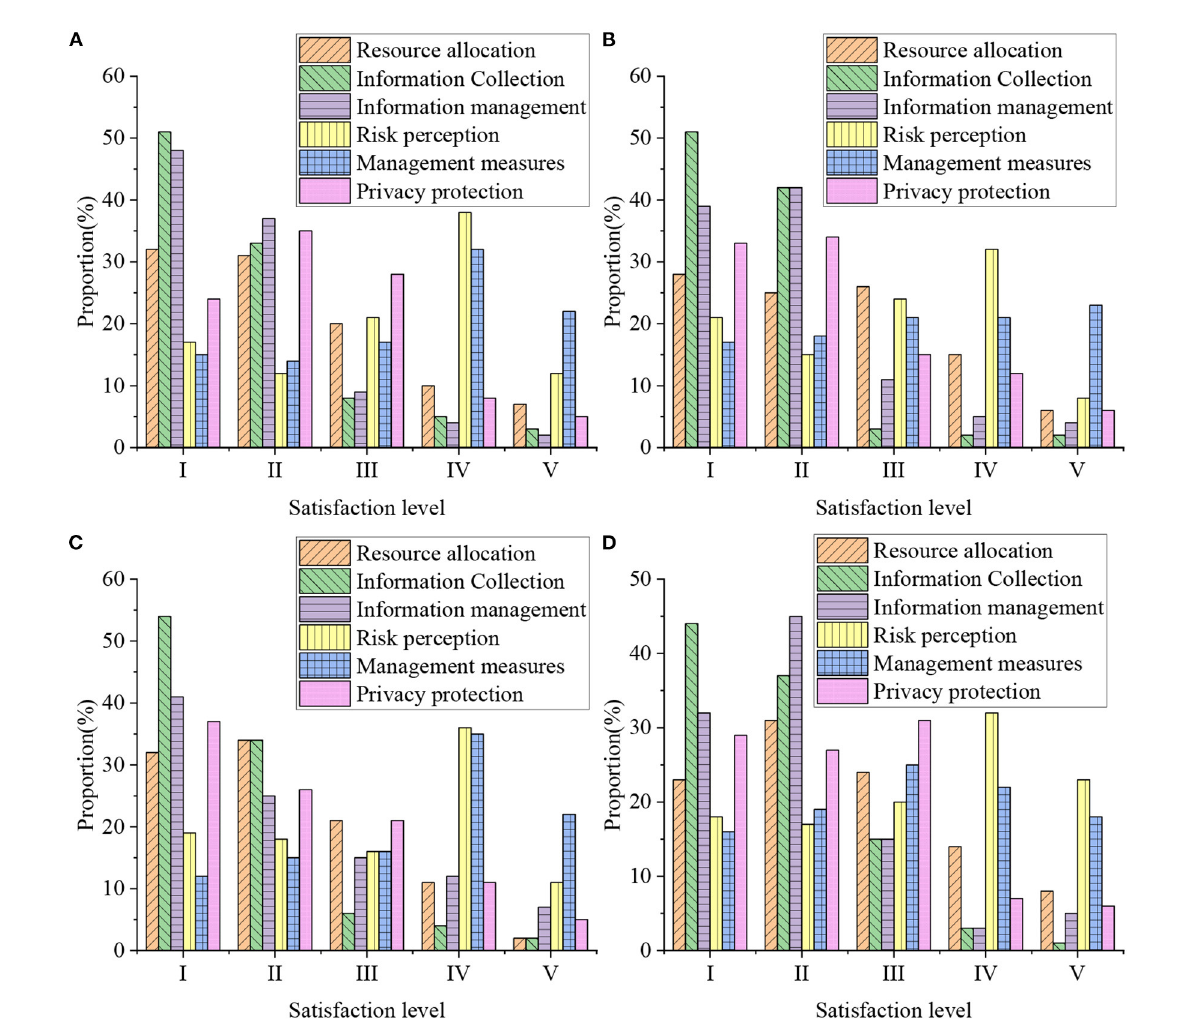
is evaluated. Figure 3 shows the specific